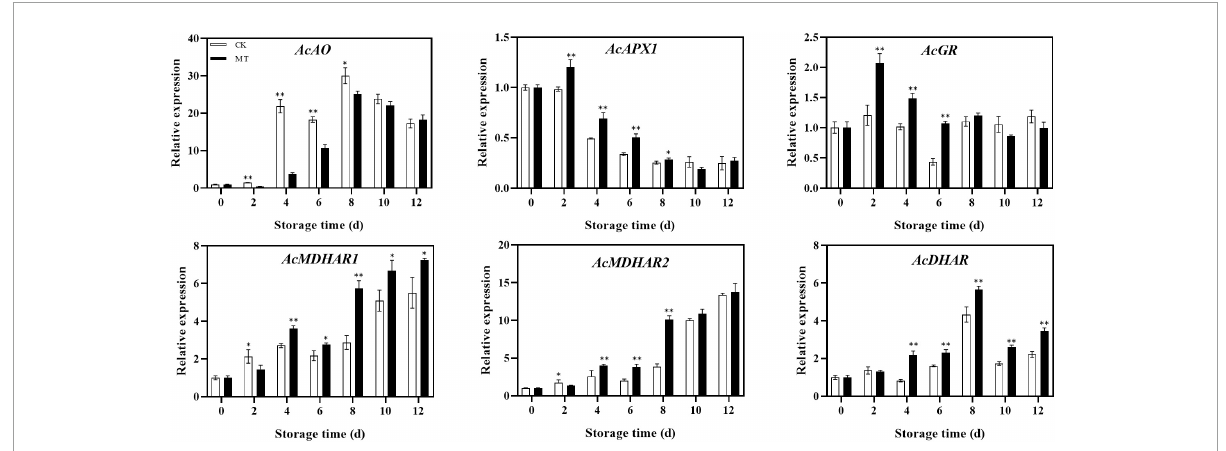
FIGURE5 Effects of melatonin (MT) treatment on expression of genes involved in ascorbic acid recycling and degradation of ‘Jinyan’ kiwifruit. Data represent the means ± SE ( n = 3). Asterisks indicate significant differences between the control and MT treatments (* P < 0.05; ** P <